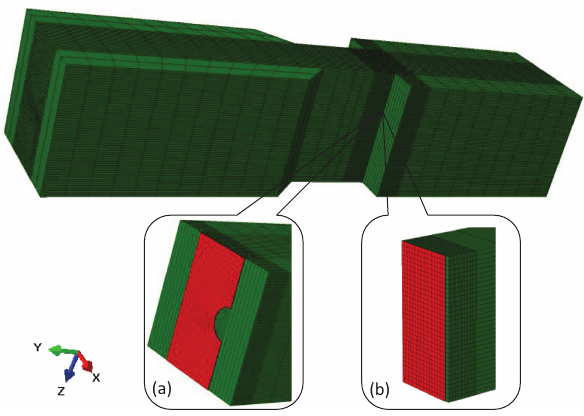
Figure 3: Finite-element meshing for semicircular (a) and straight (b) defects.